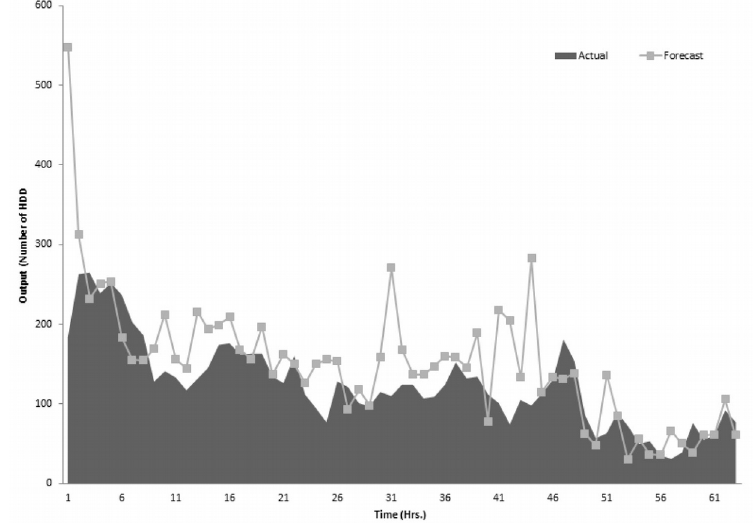
Figure 10. Current forecasting system in HDD manufacturing